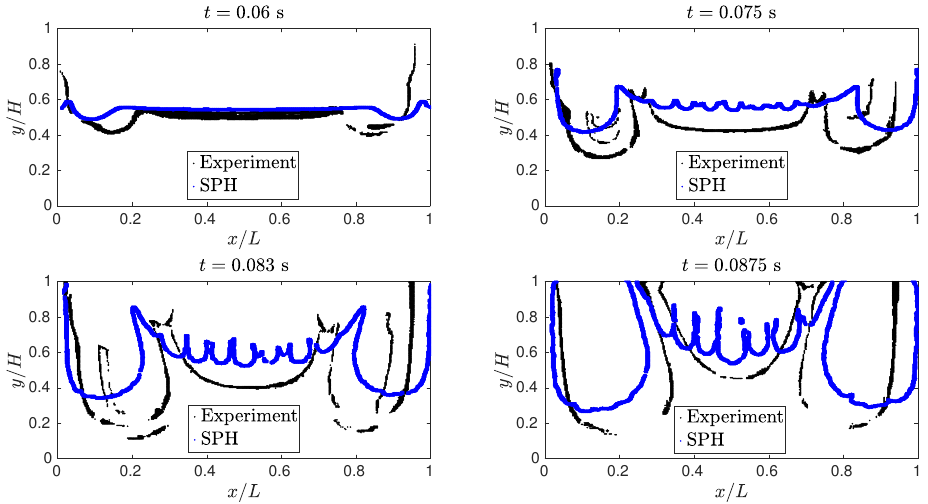
Figure 10. Comparison between the free surface position obtained by the SPH computation and the image processing obtained from experimental